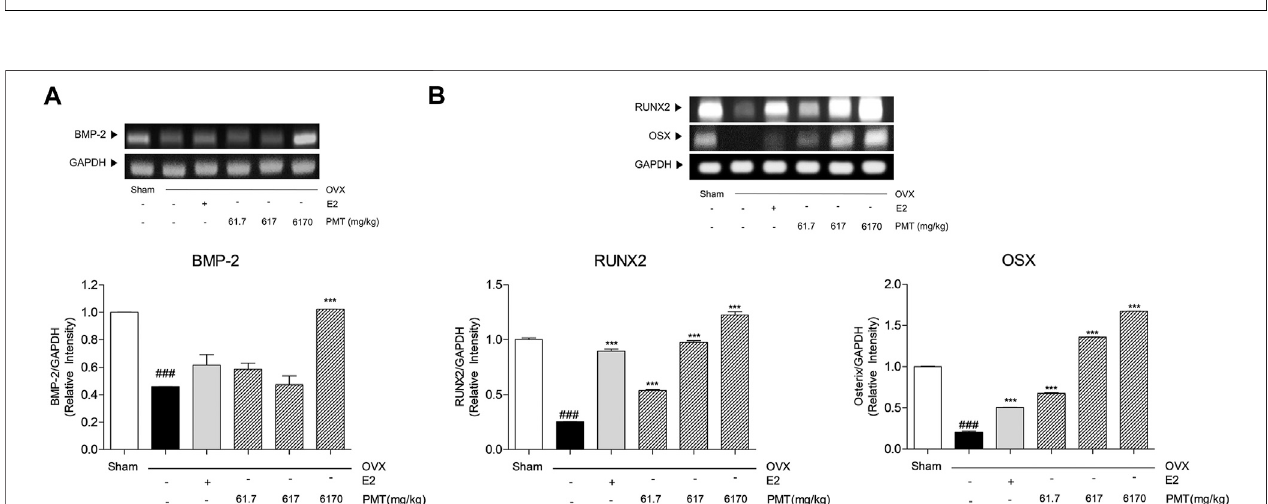
FIGURE 4 | Effects of PMT on osteoblastic differentiation initiation markers in femur. Osteoblastic differentiation initiation markers were analyzed by RT-PCR. Results are presented as the mean ± standard error. ### p < 0.001 vs. Sham group; *** p < 0.001 vs. OVX group. OVX, ovariectomized group; E2, 17 β -estradiol group; PMT, Palmul -tang soft extracts; BMP-2, bone morphogenetic protein 2; RUNX2, Runt-related transcription factor 2; OSX, osterix.